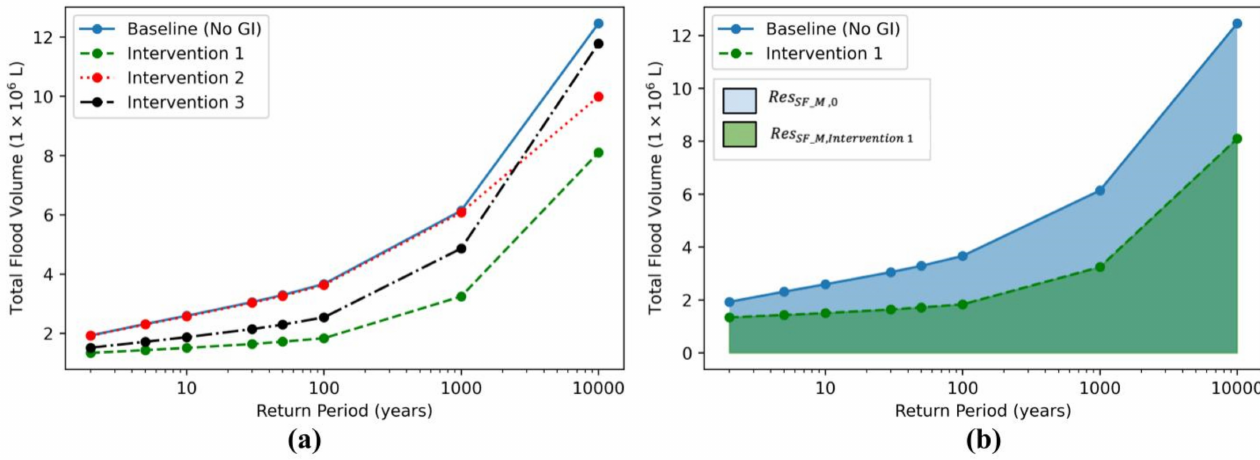
Figure 2. ( a ) Exemplification of response curve results or “stress-strain” curve: sewer flooding magnitude using different types of interventions. ( b ) Calculation of resilience metric and the net change in resilience based on the areas under the stress-strain response curve obtained. SF_M refers to sewer flood